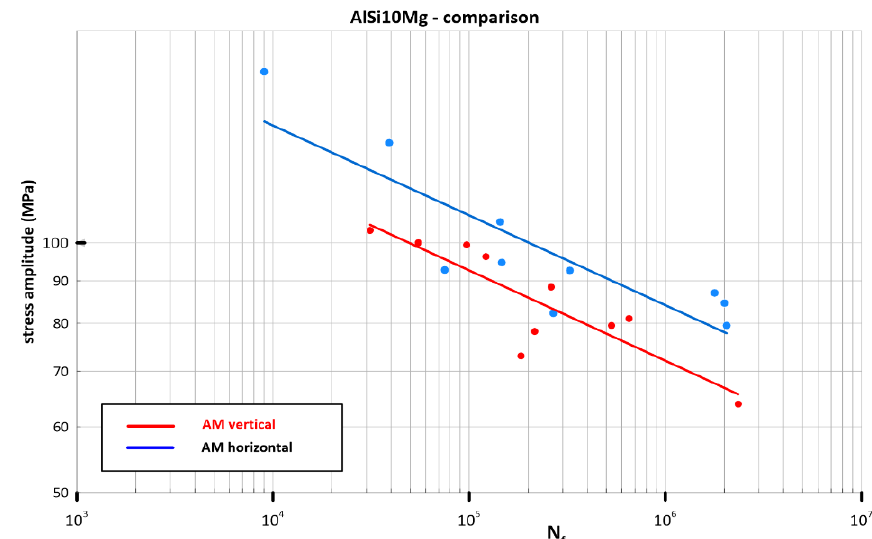
Figure 5. S-N curves of AlSi 10 Mg as a function of the deposition direction.